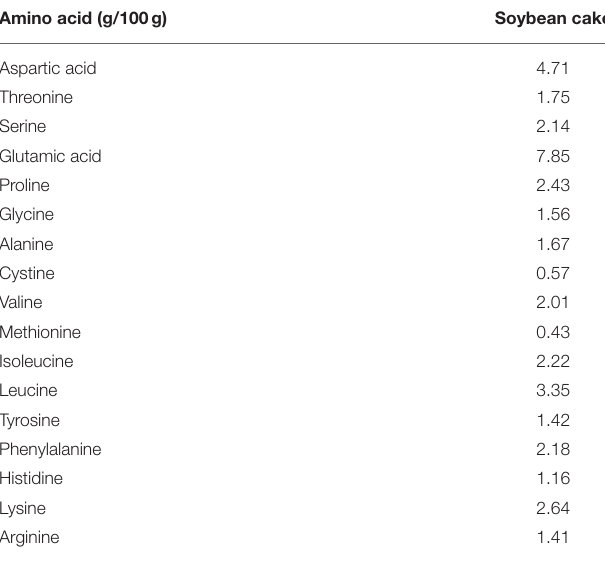
TABLE 1 | Amino acid profiling of soybean